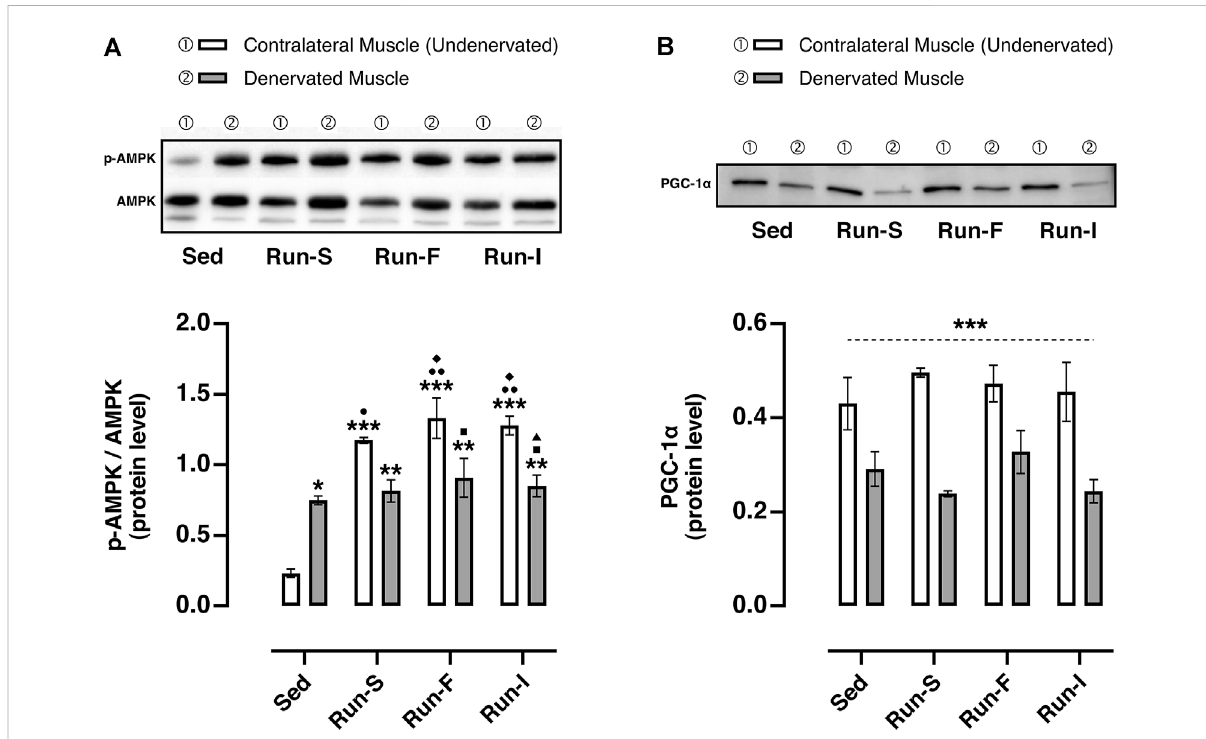
FIGURE 5 Effect of different exercise protocols on the oxidative metabolism of soleus muscle after nerve crush. (A) Representative western blot of AMPK and p-AMPK (top panel); determination of the activation level of AMPK measuring the ratio between the phosphorylated (p) and total forms (bottom panel). Two-way ANOVA, main effect type of exercise: F (3, 16) = 22.97, p < 0.001; main effect of denervation: F (1, 16) = 8.227, p = 0.011; type of exercise-by-denervation interaction effect: F (3, 16) = 14.55, p < 0.001; Tukey ’ s post hoc test: * p < 0.05, ** p < 0.01 and *** p < 0.001 vs. Sed (contralateral muscle), C p < 0.05 and CC p < 0.01 vs. Sed (denervated muscle), ◆ p < 0.05 vs. Run-S (denervated muscle), ■ p < 0.05 vs. Run-F (contralateral muscle), ▲ p < 0.05 vs. Run-I (contralateral muscle). (B) Representative western blot of PGC-1 α (top panel); quanti fi cation of protein levels of PGC-1 α (bottom panel). Two-way ANOVA, main effect type of exercise: F (3, 16) = 0.5976, p = 0.626; main effect of denervation: F (1, 16) = 44.90, p < 0.001;typeofexercise-by-denervationinteractioneffect: F (3,16)=1.019, p =0.410.*** p < 0.001indicatesthemaineffectofdenervation withrespecttothecontralateralside(undenervated)ineachgroup.DataareexpressedasmeanandSEM(denervatedmuscle:Sed n =3,Run-S n =3, Run-F n = 3 and Run-I n = 3; contralateral muscle: Sed n = 3, Run-S n = 3, Run-F n = 3 and Run-I n =